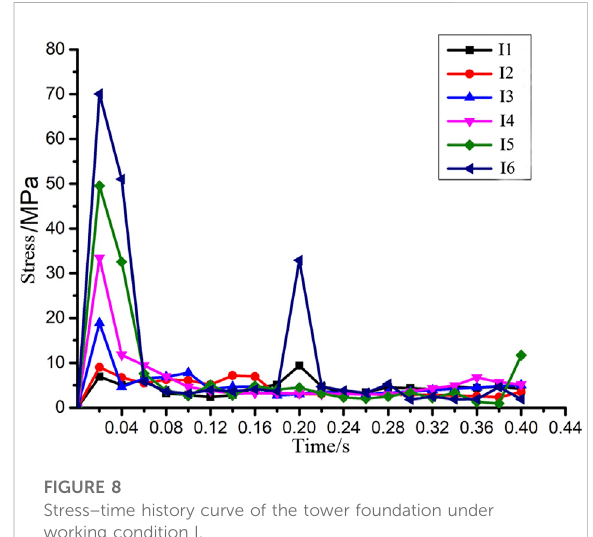
FIGURE 8 Stress − time history curve of the tower foundation under working condition I.